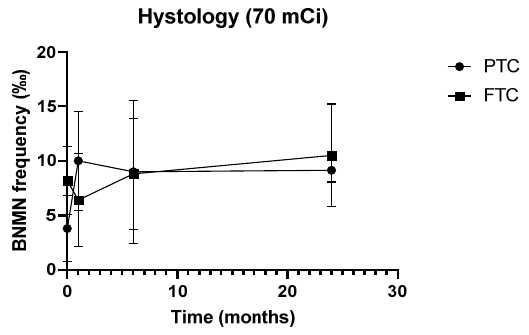
Figure 3. BNMN frequency (‰, mean ± S.D.) in DTC patients before and after (1, 6, and 24 months) therapy with 70 mCi 131 I, according to tumor histotype (papillary thyroid carcinoma (PTC) and follicular thyroid carcinoma (FTC)).